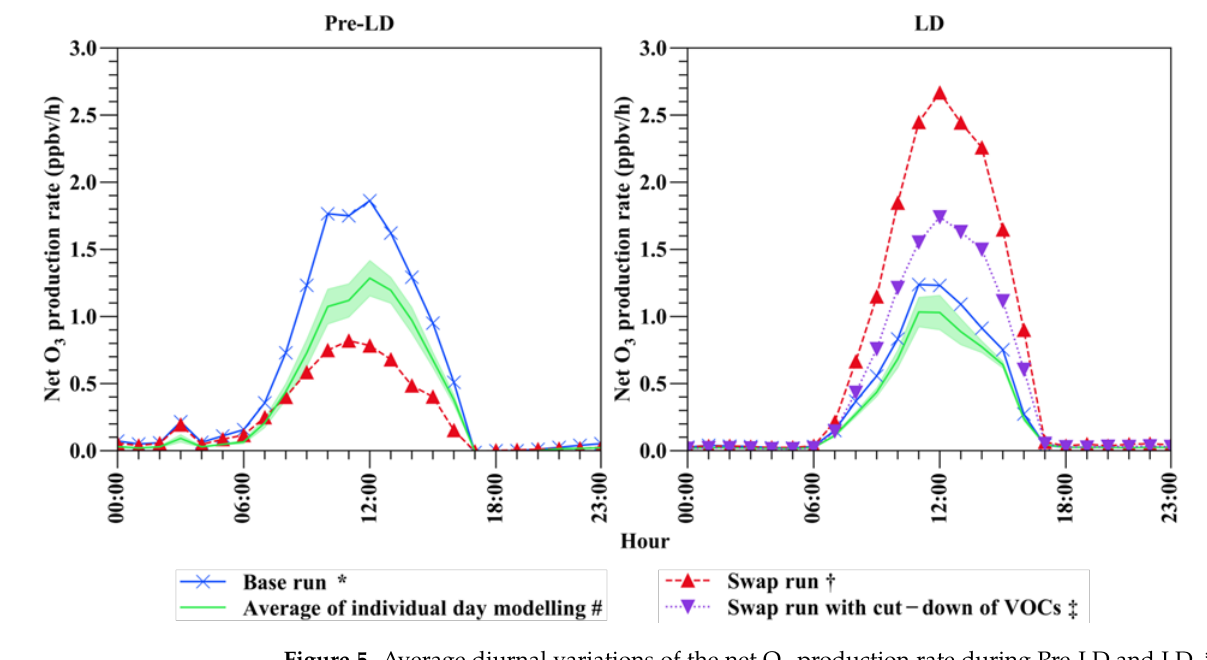
Figure 5. Average diurnal variations of the net O 3 production rate during Pre-LD and LD. * Base runs with the average profiles and no swap. # Averages of the modelling results on individual days in Pre-LD and LD, respectively (no swap). † Simulations with swap of the averaged diurnal profiles of meteorology between Pre-LD and LD. ‡ Simulation with Pre-LD meteorology and LD chemical profiles with a further cut-down of VOCs by 31.6%. Shaded area on the green line denotes the 95% confidence interval.